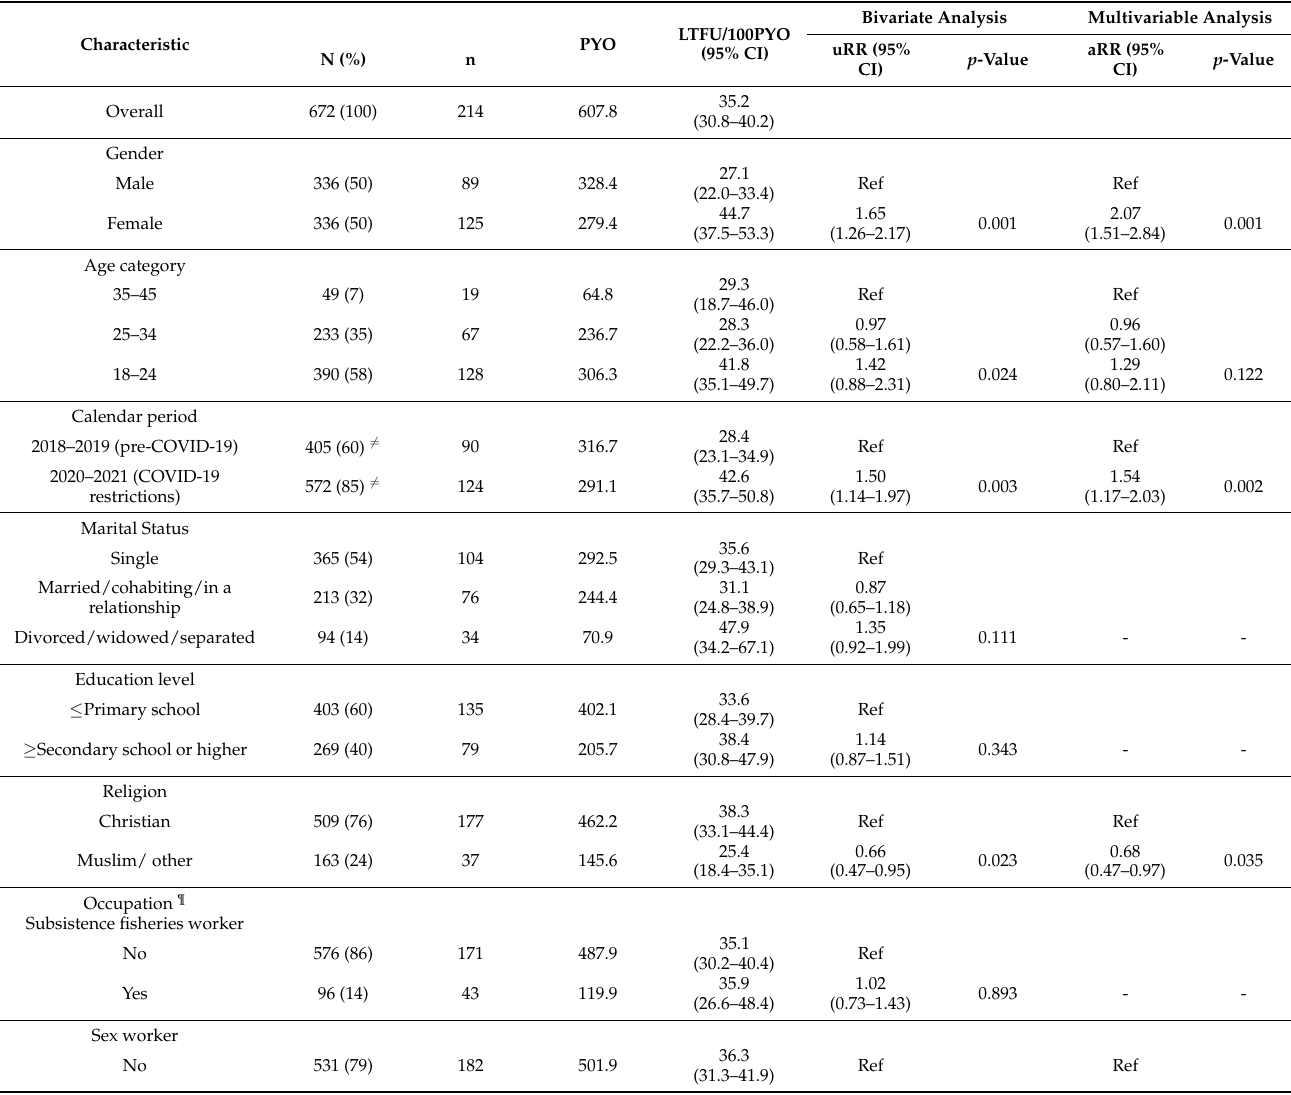
Table 1. Loss to follow-up and associated factors among 672 participants in an HIV